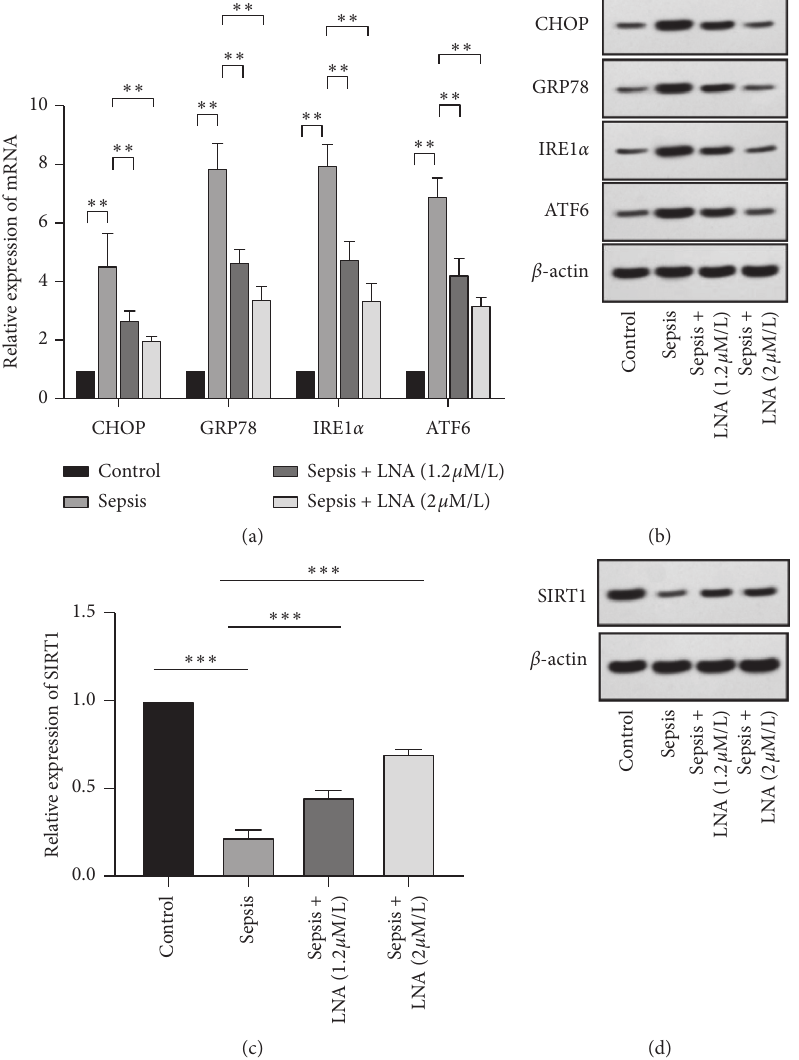
Figure 5: Lentinan reduces endoplasmic reticulum stress response in sepsis HUVECs. (a, b) mRNA and protein expressions of CHOP, GRP78, IRE1 α , and ATF6 in endothelial cells of the control group, sepsis group, sepsis+ LNA 1.2 μ M group, and sepsis+LNA 2 μ M group were measured by qPCR and Western blotting. (c, d) mRNA and protein expression of SIRT1 in endothelial cells of the control group, sepsis group, sepsis+ LNA 1.2 μ M group, and sepsis+LNA 2 μ M group were measured by qPCR and Western blotting. Values are expressed as mean ± standard deviation ( n � 3). Compared with the control group or sepsis model group, ∗∗ P < 0 . 01, ∗∗∗ P < 0 .